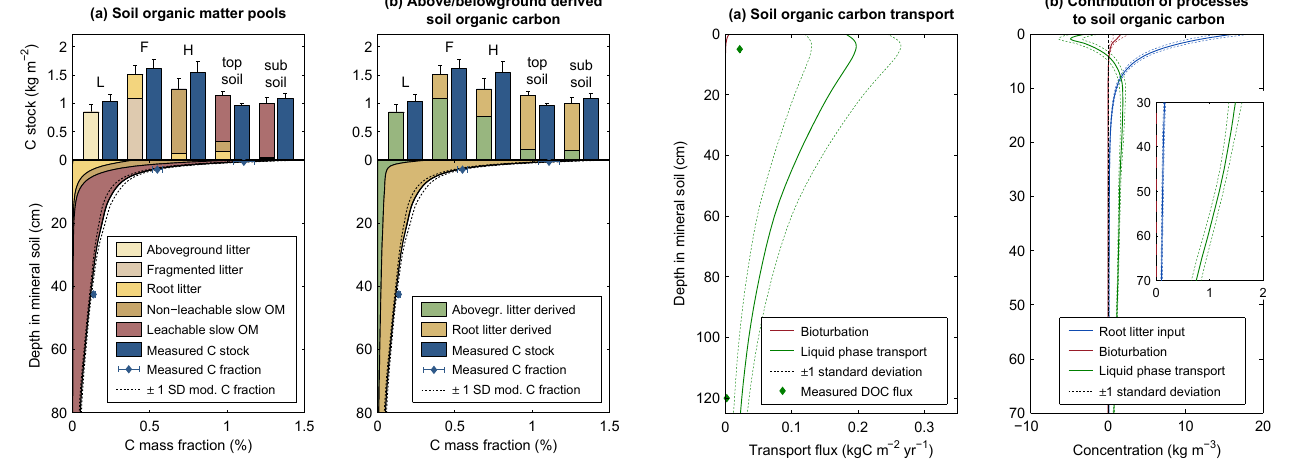
Fig. 6. Simulated organic carbon fluxes from forward Monte Carlo simulations for Loobos, based on posterior distribution of calibra- tion setup 3 (note the different scales on the y-axes). All quantities are averages over the last simulation year and the Monte Carlo en- semble. (a) Organic carbon transport fluxes and measured dissolved organic carbon (DOC) fluxes (Kindler et al., 2011; not used in the calibration). Note the indistinct bioturbation flux in the upper left corner. (b) Contributions of the different processes to soil organic matter profile in mineral soil (see Sect.